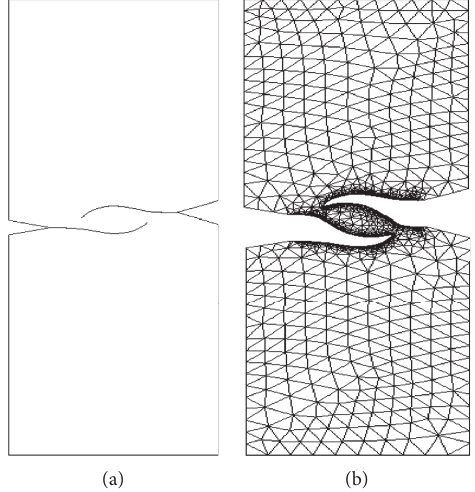
Figure 14: (a) Final crack growth path. (b) Deformed